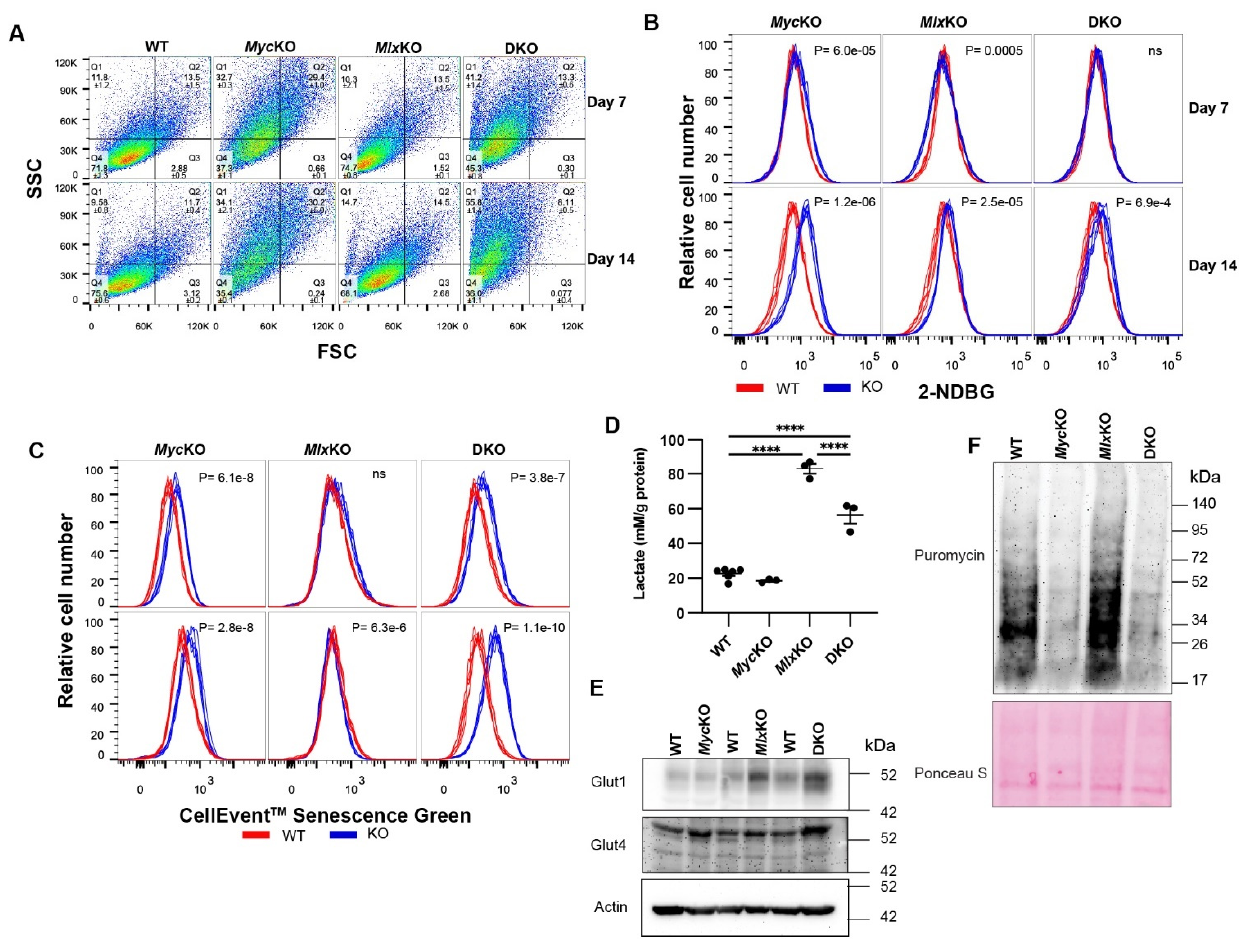
Figure 3. Variable senescence-like features of KO cells: ( A ) Side (SSC) and forward (FSC) light scatter of the indicated cell lines on days 7 and 14. Six replicates were performed for each cell line, with the mean percentages and SEs indicated in each quadrant. ( B ) Uptake of the glucose analog 2-NBDG. ( C ) Cleavage of the SA- β -Gal substrate CellEvent™ Senescence Green. In ( B , C ), the curves for six replicas are shown, with p -values between each group shown in the upper-right corner of each panel. ( D ) Lactate levels in quiescent MEFs. The indicated cell lines were re-plated on day 10 at densities high enough to allow replicative arrest of WT and Mlx KO cells to be achieved over the next 1–2 days. Non-replicating Myc KO and DKO cells were plated at densities that allowed them to achieve confluence by the next day. All cultures were then maintained for three additional days in medium containing 0.2% FCS to further consolidate quiescence, at which point lactate levels were quantified and normalized to total protein [19] . Significant differences are expressed as for Figure 1E–G. **** p < 0001. ( E ) Expression of the glucose transporters Glut1 and Glut4 in MEFs measured by immunoblotting. ( F ) Rates of protein synthesis in the indicated MEFs. Subconfluent cultures of d10 MEFs were labeled with puromycin for one hour, lysed, and subjected to SDS-PAGE before probing with an anti-puromycin antibody. Equal protein loading was confirmed by Ponceau red